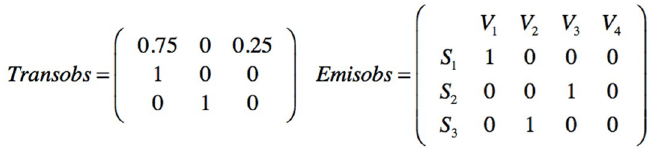
Figure 29. Posterior transition and emission matrices obtained from a new observation.